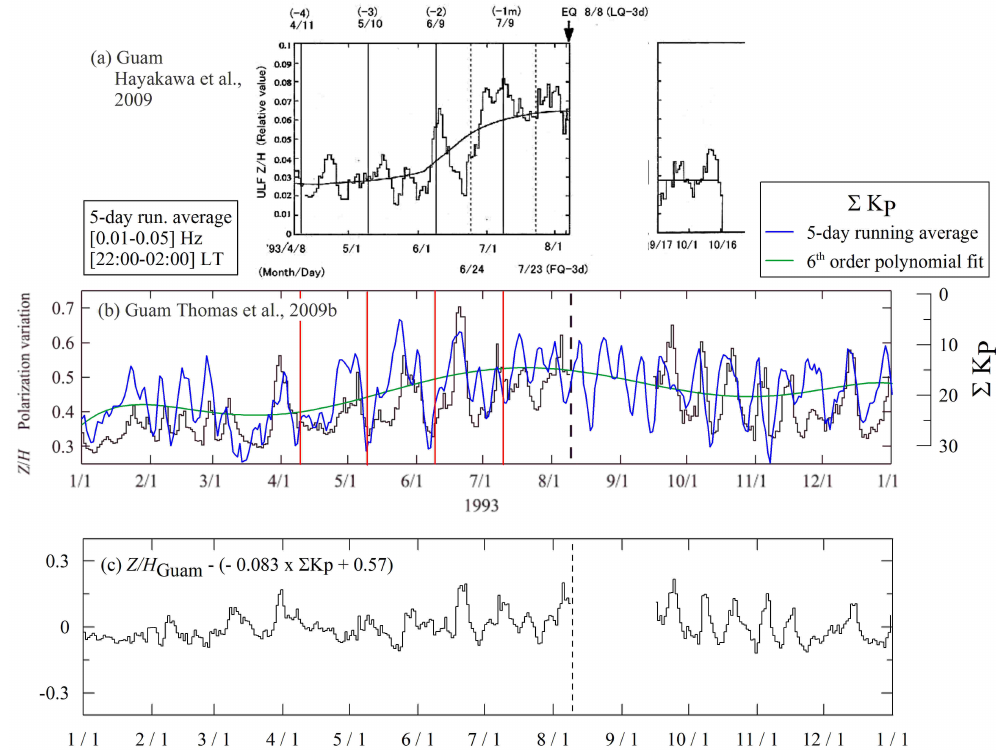
Fig. 2. (a) Lunar phase analysis for the Guam polarization ratio Z/H as reported by Hayakawa et al., (2009) (a reproduction of Hayakawa et al., 2009, Fig. 3). (b) ULF polarization ratio Z/H (5-day running average) as reported by Thomas et al. (2009b); the 5-day running average (blue line) and the 6th order polynomial fitting (green line) of 6 Kp are shown as well. (c) Residual of the linear relationship between the Z/H ratio shown in panel (b) and 6 Kp as reported by Masci (2011) (a reproduction of Masci, 2011, Fig. 1). See Thomas et al. (2009b) and Masci (2011) for